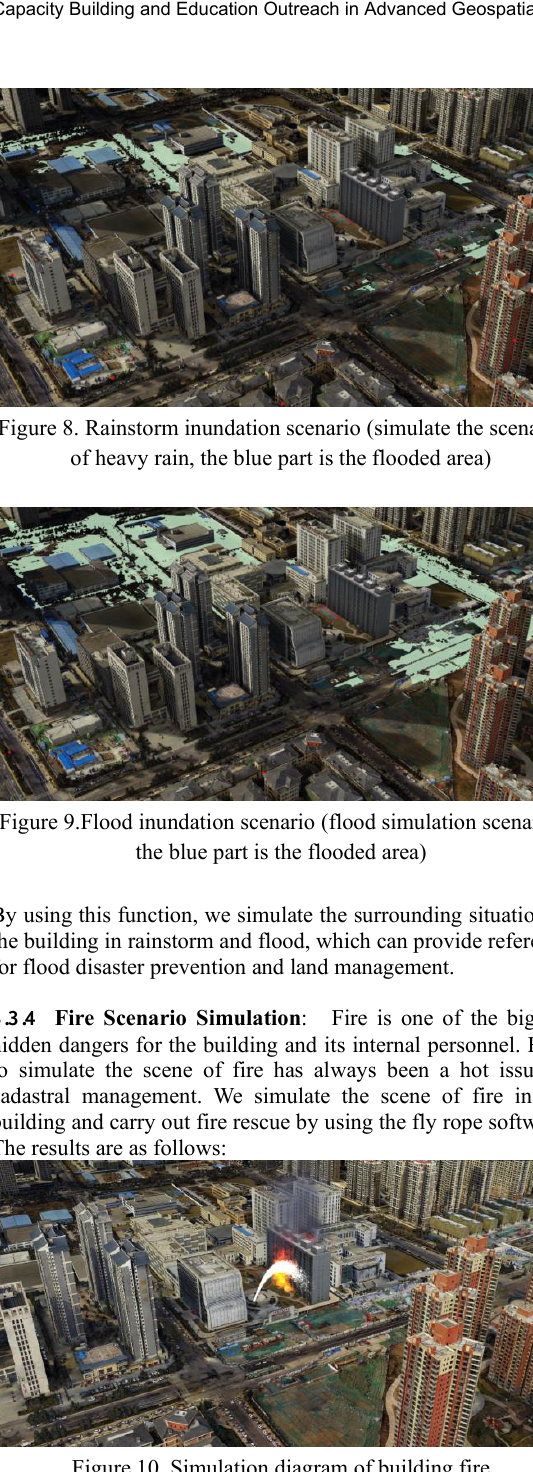
Figure 10. Simulation diagram of building fire